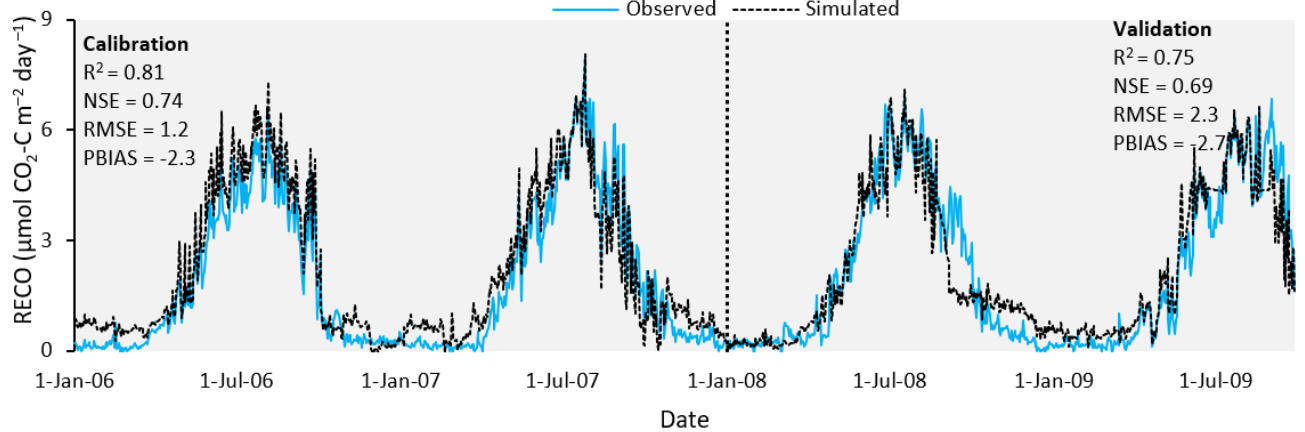
Figure 7. Predicted and observed daily RECO in the calibration and validation periods.